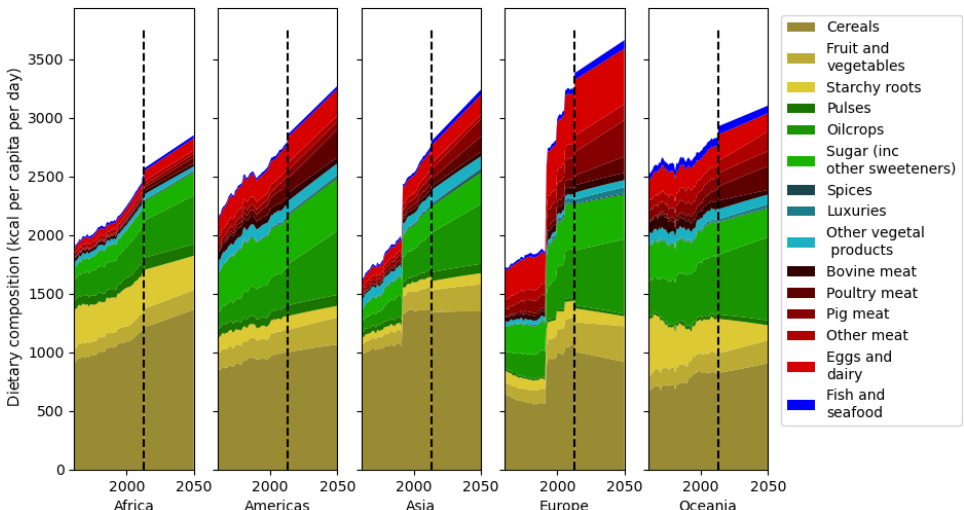
Figure 3. Calorific mean diet composition at the continent level in historical FAOSTAT data and the C-LLAMA anchor scenario. Some food commodities are grouped for clarity, and the order of appearance from the origin for the groups aligns with the legend.